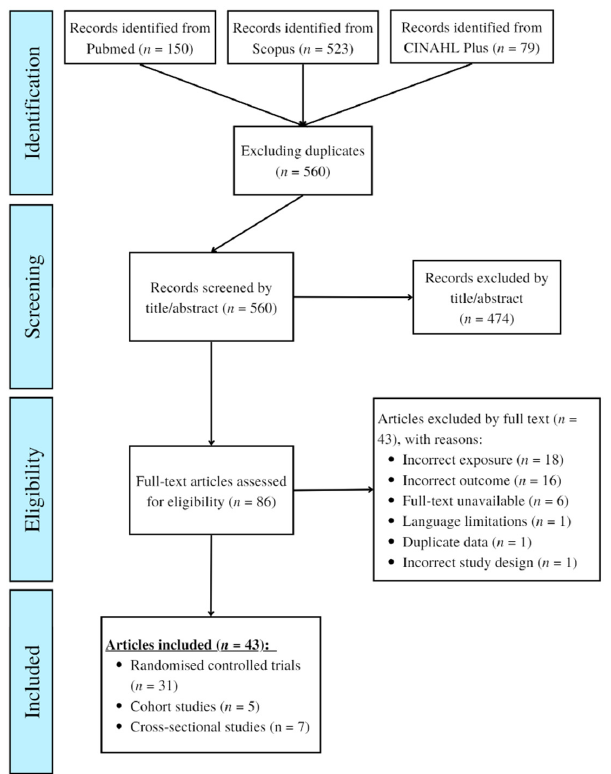
Figure 1. Flow Chart of Database Search and Article Eligibility.